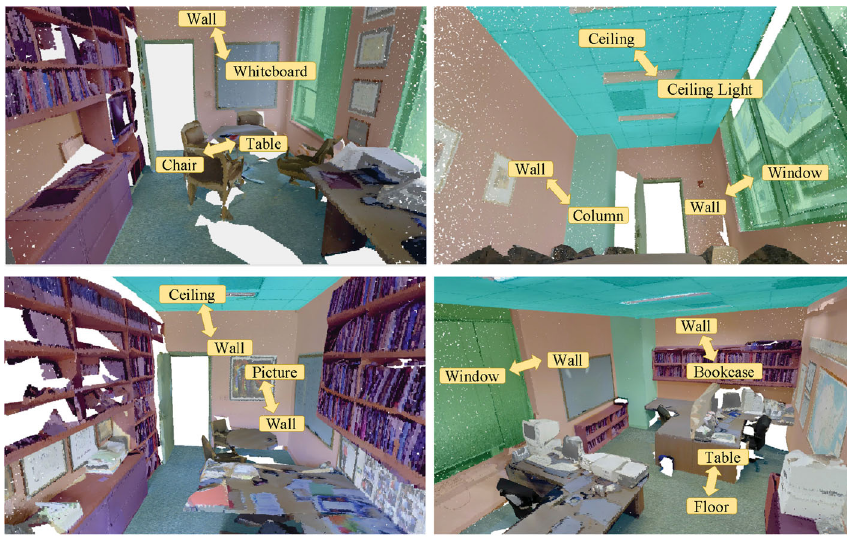
Fig. 1 Co-occurring category pairs in local regions from scenes in S3DIS